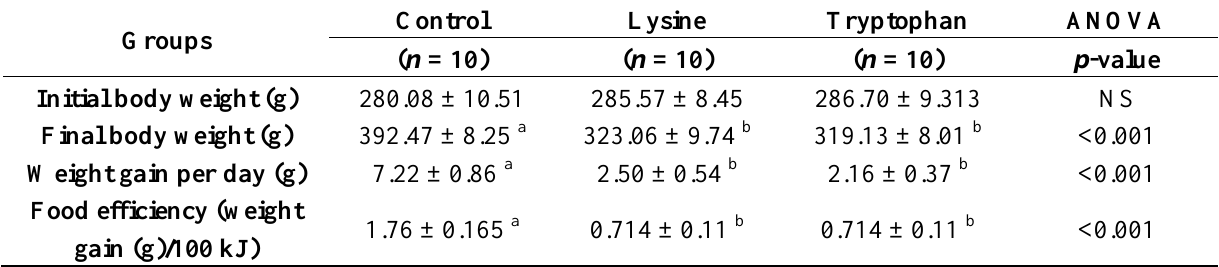
Table 2. Mean weight (g), weight gain and food efficiency of rats fed on diets supplemented with 5% lysine or tryptophan.